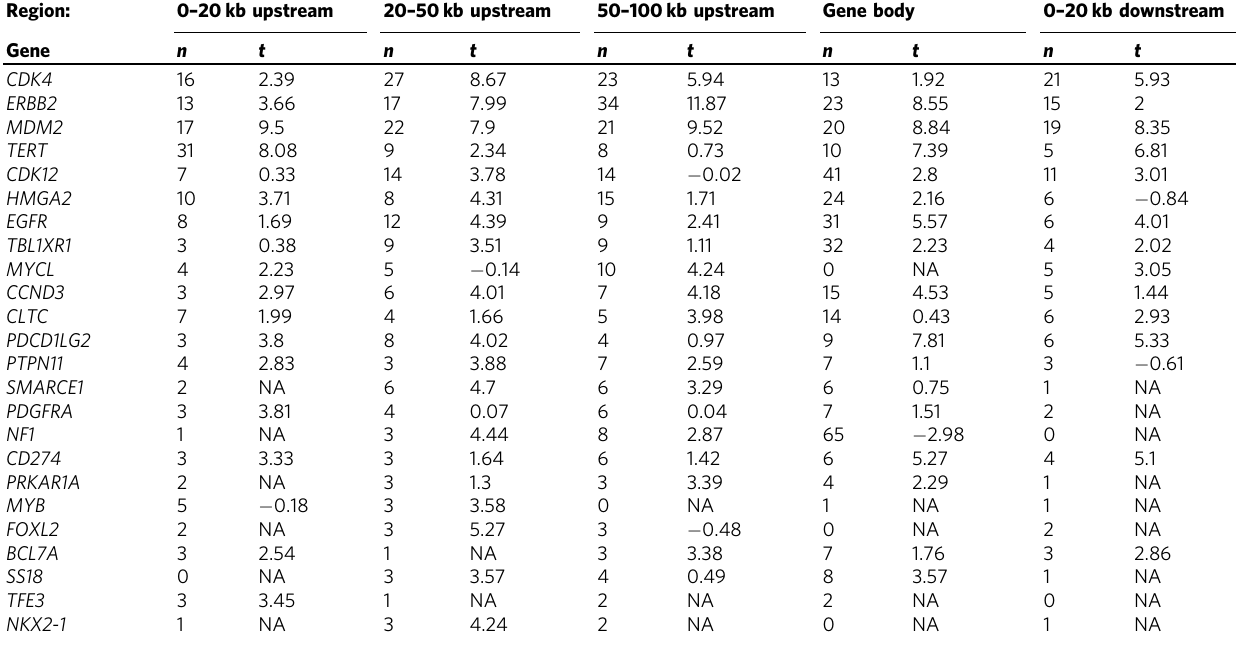
Tableliststhegenespositivelycorrelatedinexpression( p <0.001andFDR<4%,correctedforcopynumberandcancertype)withoccurrenceofupstreamSVbreakpoint,withthegenebeingpreviously associated with cancer. Previous cancer association based on membership in the Sanger Cancer Consensus Gene list (http://www.sanger.ac.uk/science/data/cancer-gene-census). Number of cancer cases with SV in given region ( n ) is from the set of 1220 cases with both expression and SV data. t -statistic ( t ) based on linear regression model incorporating both cancer type and copy number in addition to SV event; a t -statistic of 3.3 or more approximates to p <0.001 or FDR<4%. Genes with p <0.001 for 0 – 20kb upstream, 20 – 50kb upstream, or 50 – 100kb upstream regions are included here. “ NA ” , not assessed (less than three cases involved). See also Supplementary Data